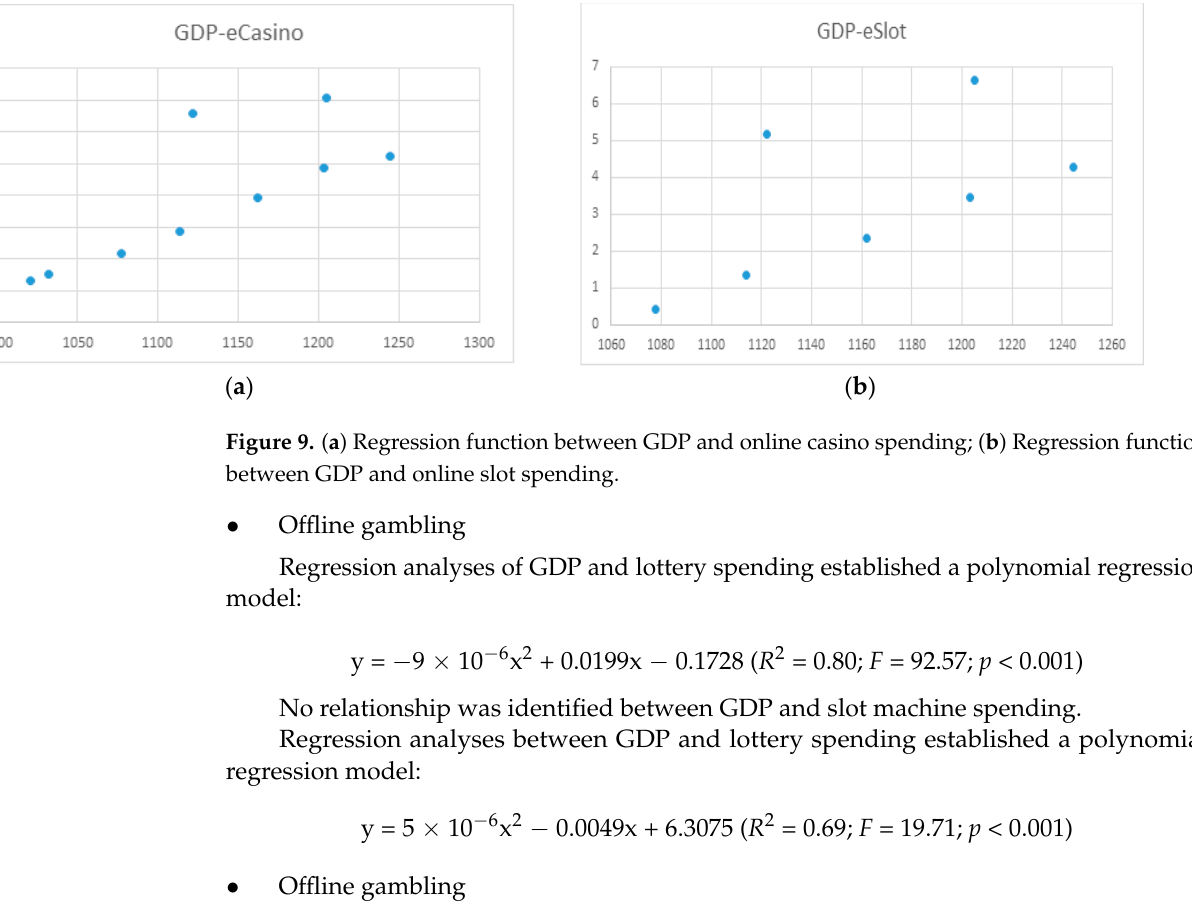
9 of 15 Figure 7. Regression function between GDP and casino spending. Regression analyses between GDP and lottery spending established a polynomial re- gression model: y = 5 × 10 − 6 x 2 − 0.0049x + 6.3075 ( R ² = 0.69; F = 19.71; p < 0.001) • Offline gambling ( a ) ( b ) Figure 8. ( a ) Regression function between GDP and online poker; ( b ) Regression function between GDP and online sports betting.